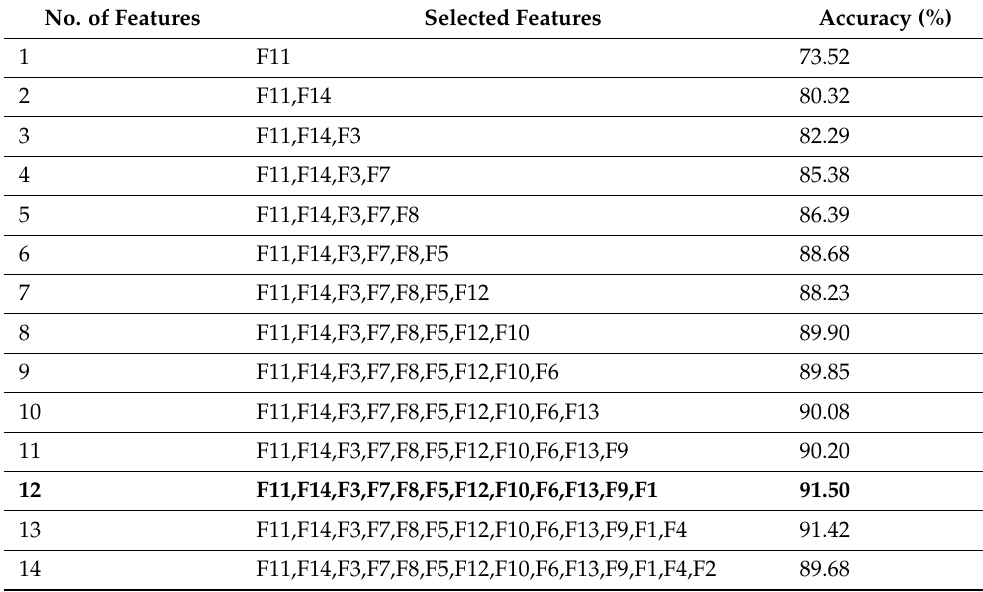
Table 5. Performance of fault detection using SFS with ANN (five-fold cross-validation).